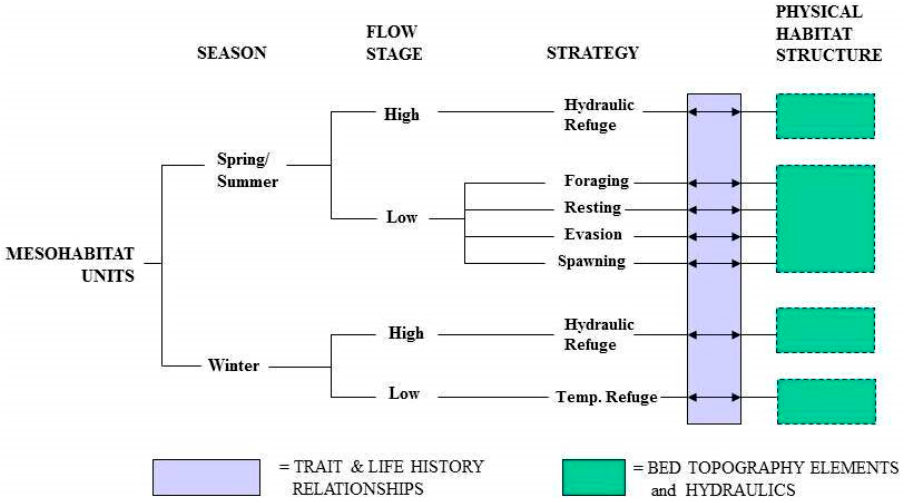
Figure 3. Conceptual framework for developing a mesohabitat classification scheme for low-gradient Midwestern headwater streams applying species trait and life history relationships.